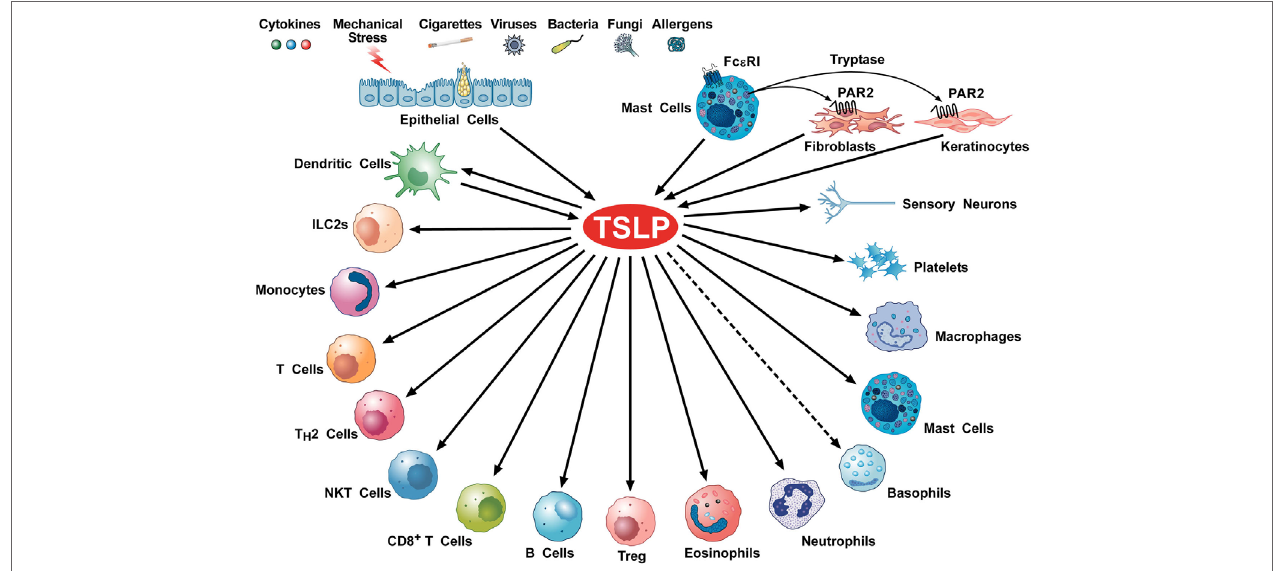
FiGURe 2 | Schematic representation of cellular targets of thymic stromal lymphopoietin (TSLP). Several triggers can activate lung and gut epithelial cells and keratinocytes to release TSLP. This cytokine can also be produced by activated mast cells (28, 55–57) and dendritic cells (DCs) (26, 58). Tryptase, released by mast cell activates the protease-activated receptor 2 receptor on fibroblasts (53, 59) and keratinocytes (53) to release TSLP. TSLP activates DCs (37, 44, 60), ILC2 (61–63), CD4 + T and Th2 cells (64, 65), NKT cells (66), CD8 + T cells (67) and B cells (68, 69), Treg (35, 70), eosinophils (71, 72), neutrophils (73), murine (74), but not human basophils (9), monocytes (75), mast cells (16, 76–78), macrophages (79), platelets (80, 81), and sensory neurons